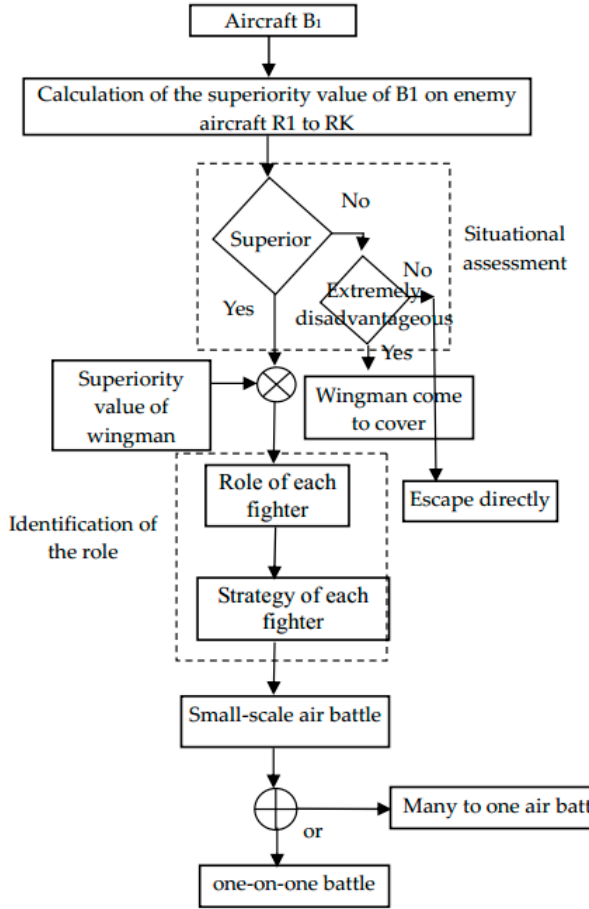
Figure 4. Flowchart for each fighter deciding attack/escape and role in a team.